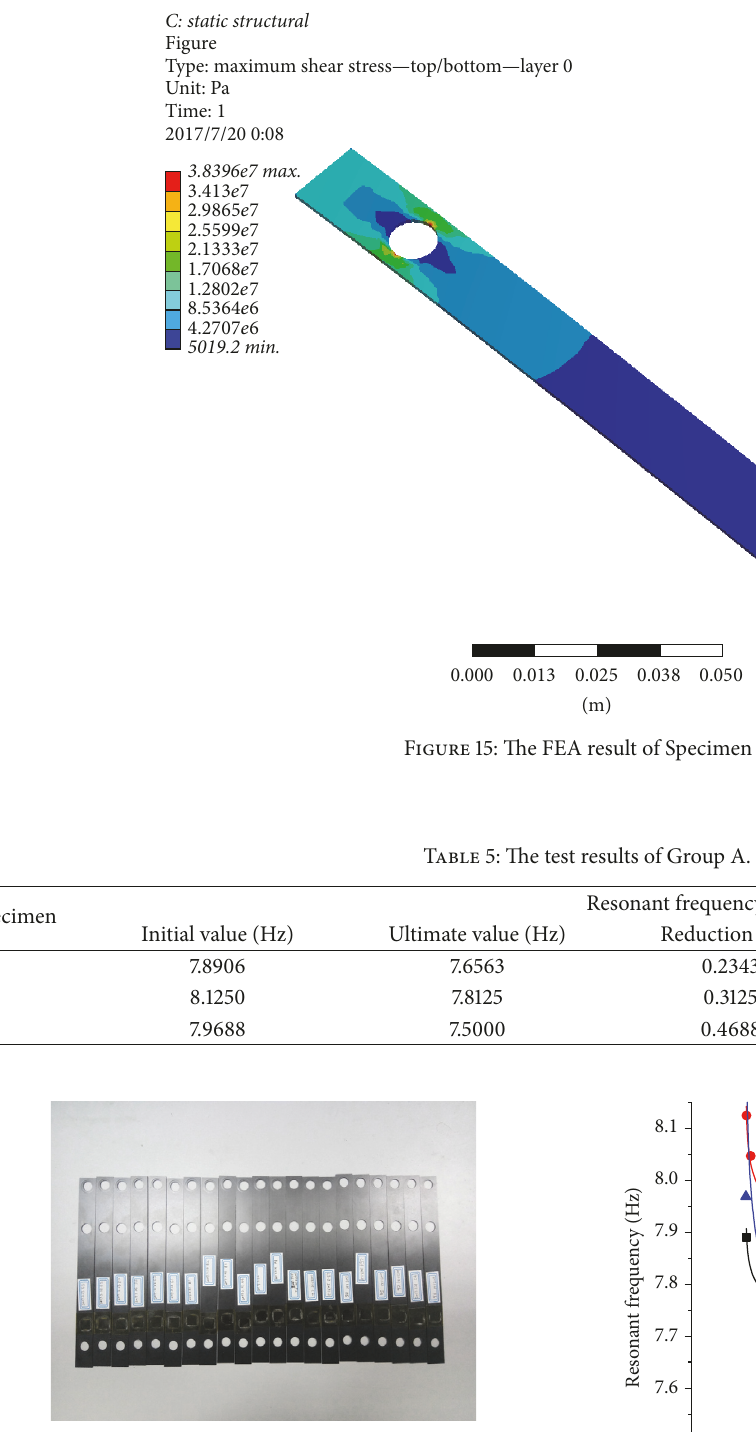
Figure 16: Some of the damaged test specimens.